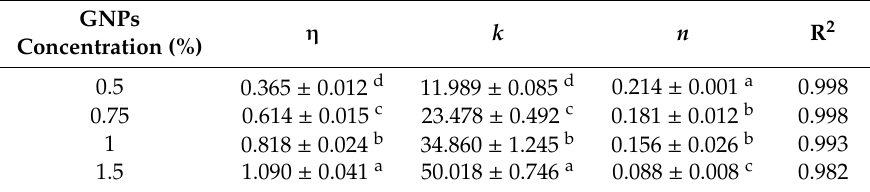
Table 1. The apparent viscosity ( η ), consistency index ( k ), and flow behavior index ( n ) of Pickering emulgels with gliadin nanoparticles (GNPs) concentration.